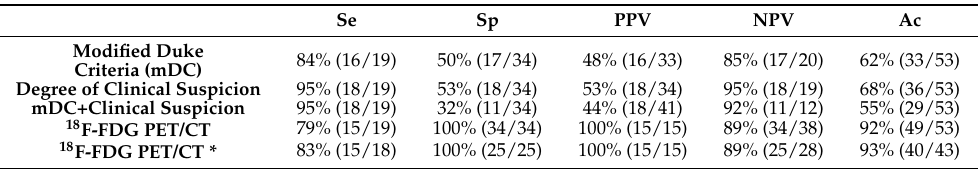
Table 2. Overall diagnostic results compared to the final diagnosis, according to the Endocarditis Team consensus.